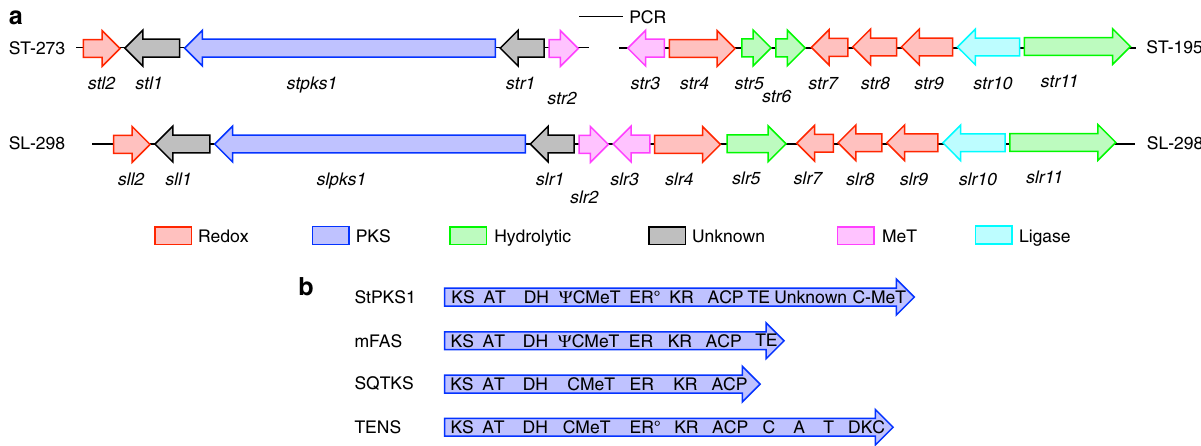
Fig. 2 Map of the strobilurin biosynthetic gene clusters in S. tenacellus and S. lutea . a Annotated ca 47 kb biosynthetic gene clusters contained in the S. tenacellus and S. lutea genomes (not to scale); b domain structure of known fungal highly reducing polyketide synthases. KS: keto-synthase, AT: acyl- transferase, DH: dehydratase, C- MeT: C -methyltransferase; Ψ C- MeT: non-functional C- MeT, ER: enoyl-reductase, ER ˚ : non-functional ER, KR: keto- reductase, ACP: acyl carrier protein, TE: thiolesterase, C: condensation domain, A: adenylation domain, T: thiolation domain, DKC: Dieckmann cyclase, StPKS1: S. tenacellus polyketide synthase 1, mFAS: mammalian fatty acid synthase, SQTKS: squalestatin tetraketide synthase, TENS: tenellin